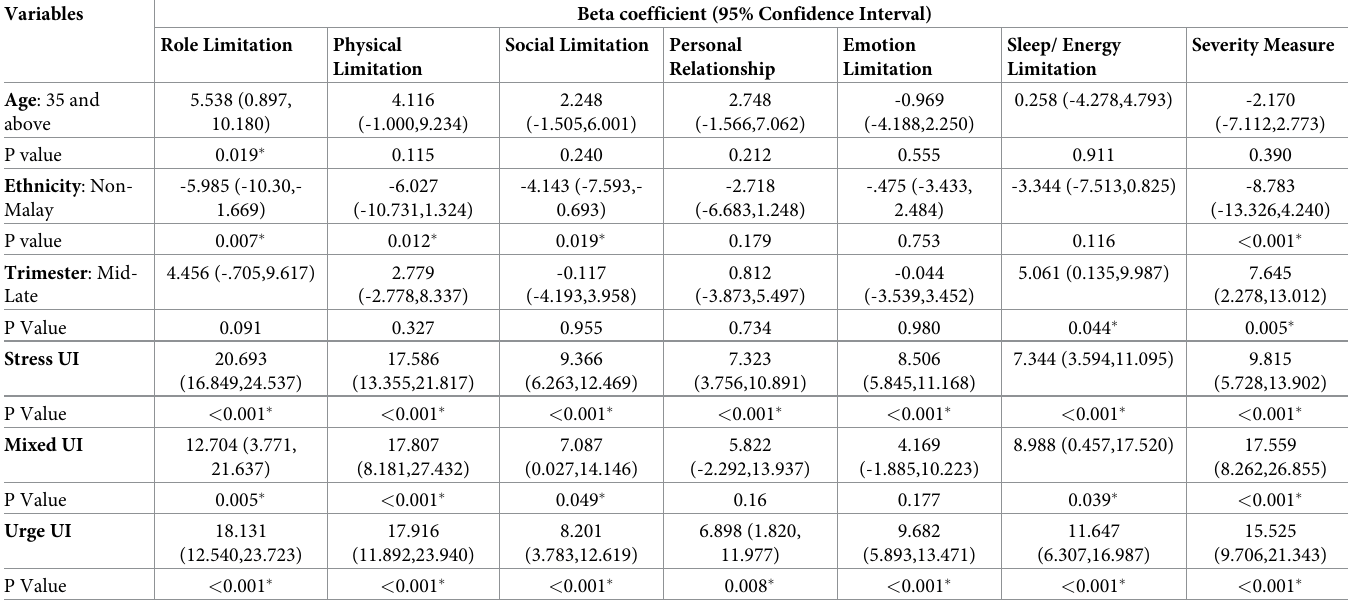
Table 4. Multivariate analysis of the significant predictors of QoL among pregnant women.